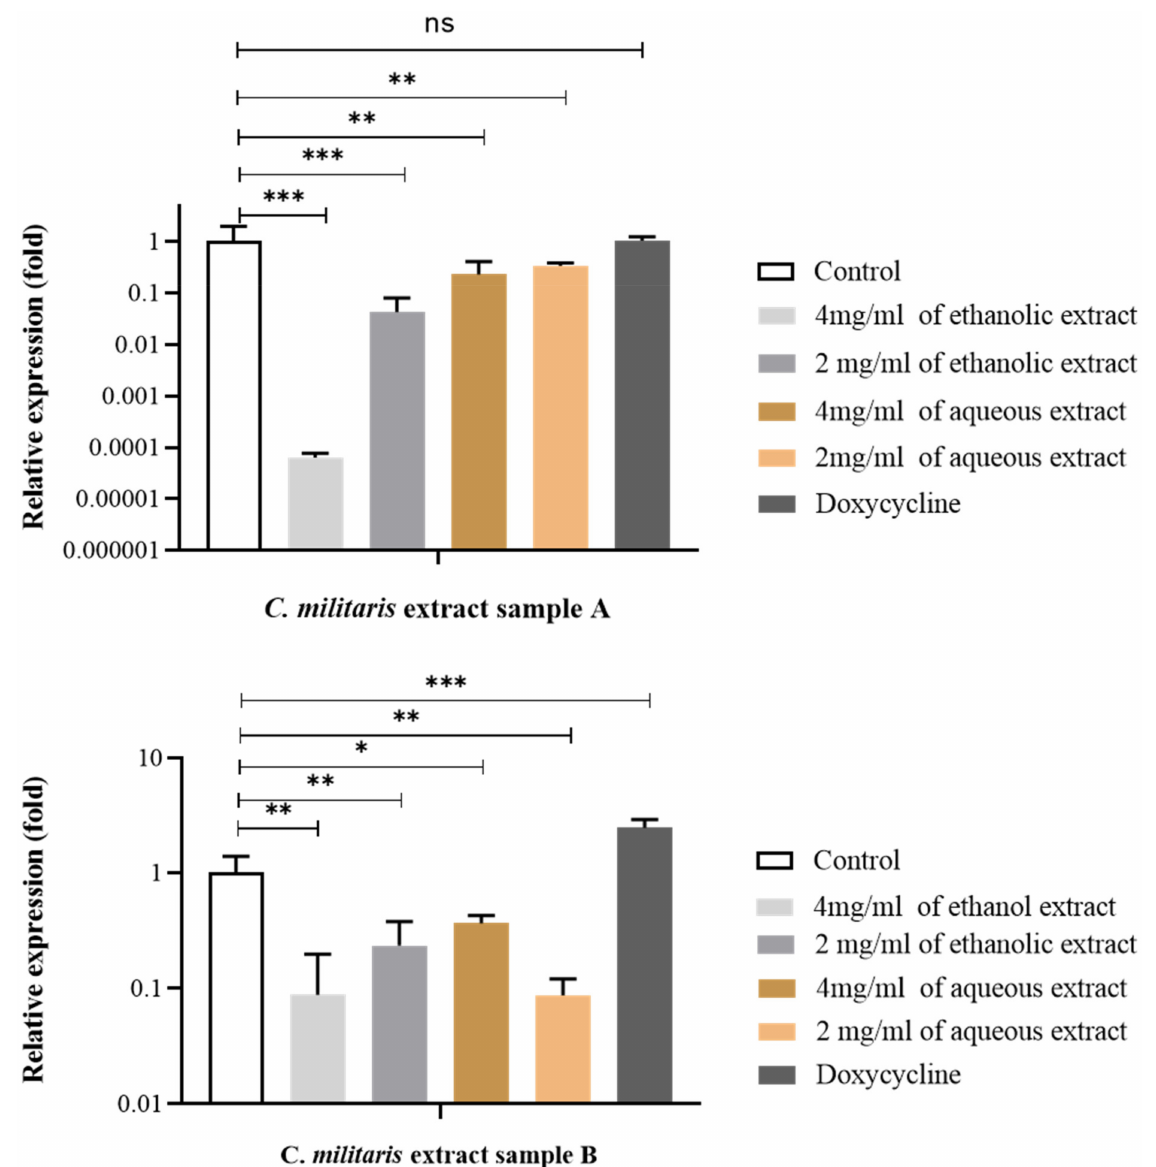
Figure 5. The relative mRNA expression of mecA gene on MRSA after treatment with the aqueous and ethanolic extract of C. militaris sample ( A , B ). The expression of mecA gene was compared to the untreated control. Gene expression ratios of MRSA were normalized and compared to the expression of the regulator gene. * indicates p < 0.033, ** p < 0.002, *** p < 0.001, and Not significant